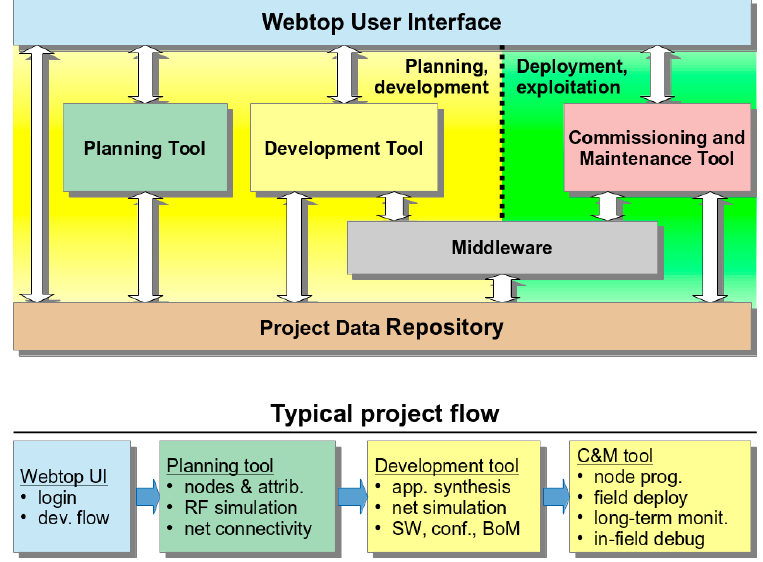
Figure 3. Overview of the WSN-DPCM Toolset communication and typical development flow.